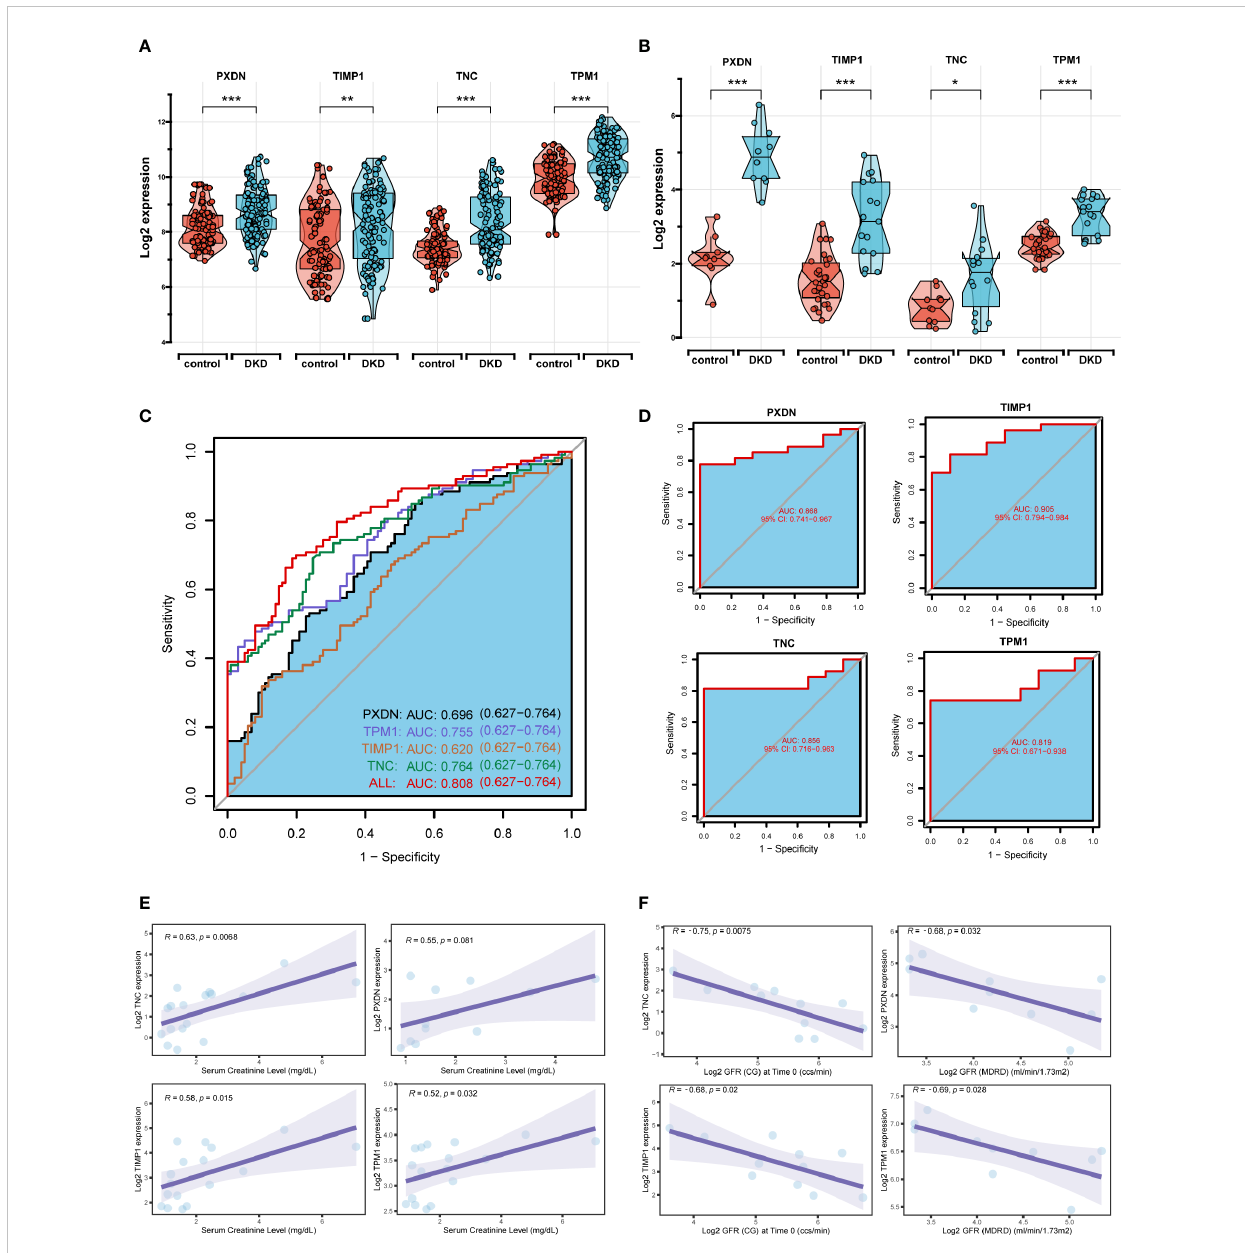
FIGURE 5 Diagnostic ef fi cacy and external veri fi cation of diagnostic markers. (A, B) The 4 diagnostic markers expression in seven DKD pooled datasets (A) and external datasets (B) . (C, D) Receiver operating characteristic (ROC) curves assessing the diagnostic ef fi cacy of four diagnostic markers in seven DKD combined datasets (C) and GSE142025 dataset (D) . (E, F) Correlation analysis of gene expression levels with creatinine (E) and glomerular fi ltration rate (GFR) (F) . ****P < 0.001, ***P < 0.005, **P < 0.01, *P <